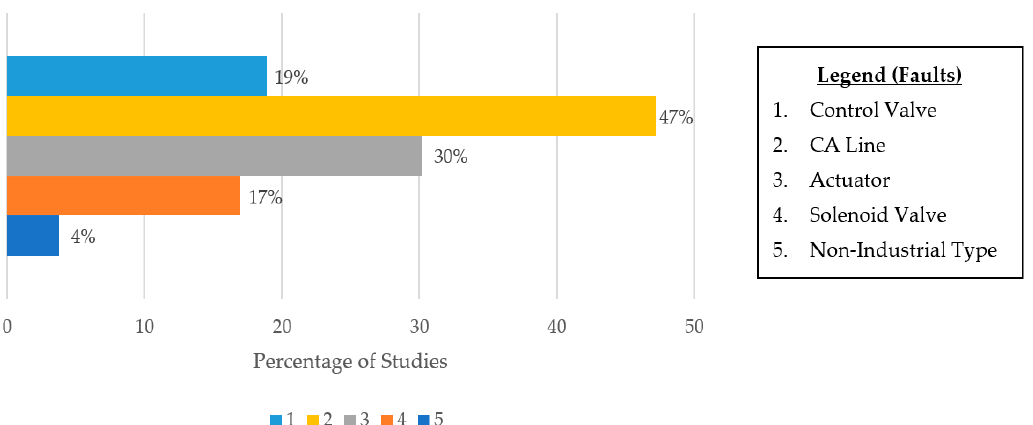
Figure 3. Main topics concerning demand-oriented pneumatic fault detection covered in this review.